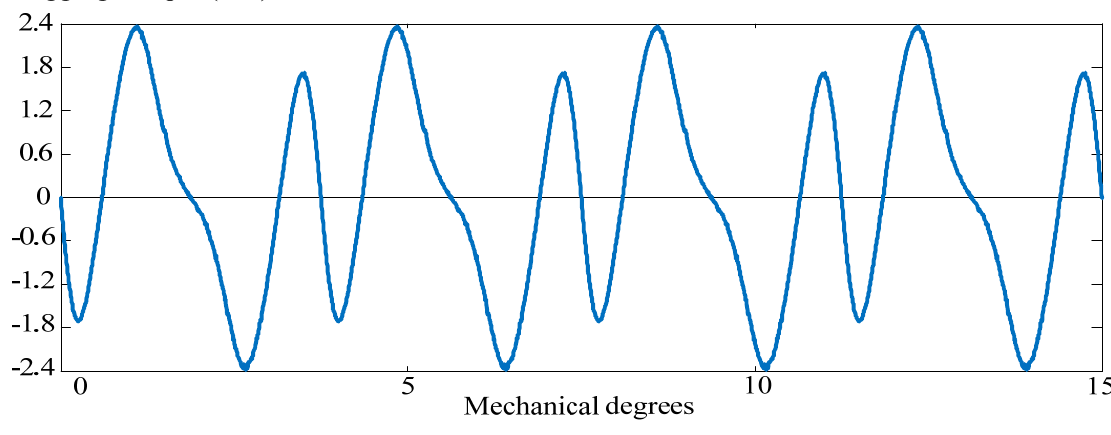
Figure 9. Complete cogging torque of 100-pole, 96-slot machine manipulated by